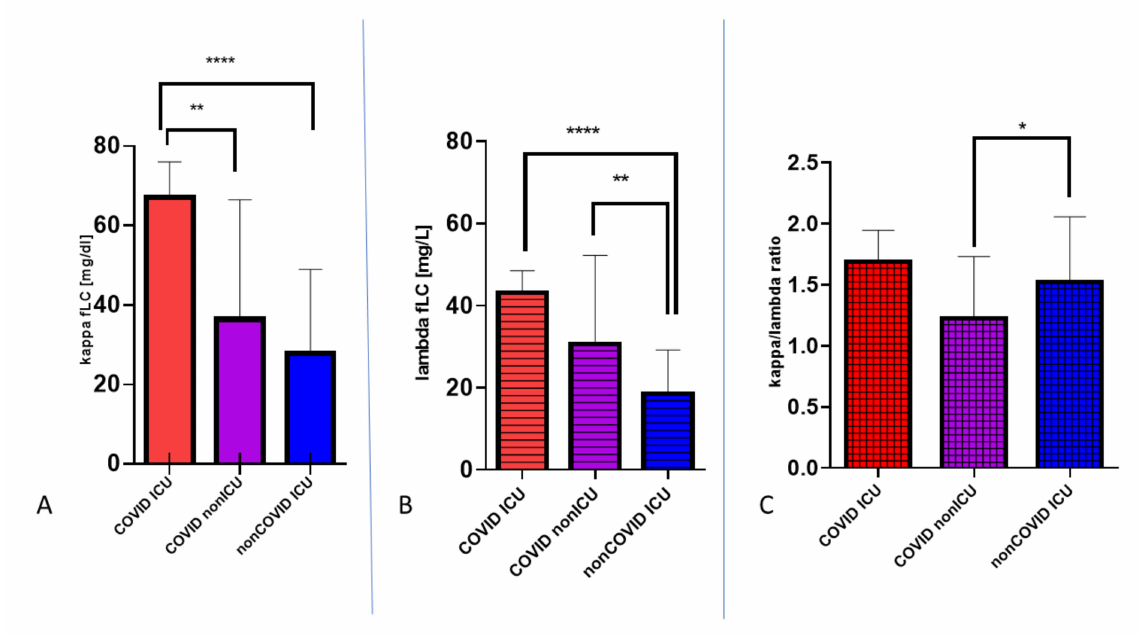
Figure 4. The concentration of FLC chains in three groups of patients (COVID-19 patients hospitalized in the intensive care unit, COVID-19 patients hospitalized in the other units, and non-COVID-19 patients hospitalized in the intensive care unit). A— κ FLCs; B— λ FLCs; C— κ / λ ratio.(* p < 0.05, ** p < 0.01, **** p <